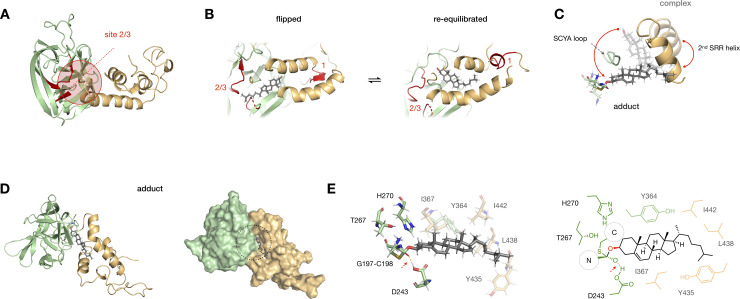
Photocrosslinking and MD analysis suggest dynamic cholesterol binding at the Hint-SRR interface.(A) A sphere encompassing residues within 10 Å of identified crosslinking sites 2 and 3 (red) in the hSHH apo Hog model. (B) Model of a “flipped” cholesterol-Hog complex, in which cholesterol is rotated 180° relative to its original pose. MD equilibration of the “flipped” cholesterol for 400 ns returns cholesterol to its original orientation (see S1 Movie). (C) Overlay of cholesterol, the 2nd SRR helix, G197-C198 thioester, and SCYA loop in the cholesterol-Hog complex (semi-transparent) and the Hog-cholesterol adduct (full color). The red arrow indicates overall movement of cholesterol past the flexible SCYA loop during this transition (see S2 Movie). (D) Cartoon and surface representations of the Hog-cholesterol adduct; the thioacetal adduct is indicated by a black dashed circle. (E) Expansion of the thioacetal adduct, showing active site residues (full color) and Hint-SRR residues near cholesterol (semi-transparent). The H-bond between the G197 oxyanion and the protonated side chain of D243 is indicated by a dashed red line.